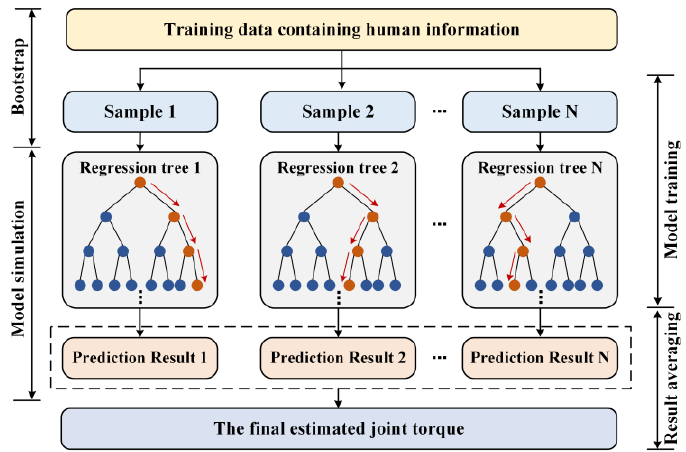
Figure 5. Schematic diagram of RFR algorithm.